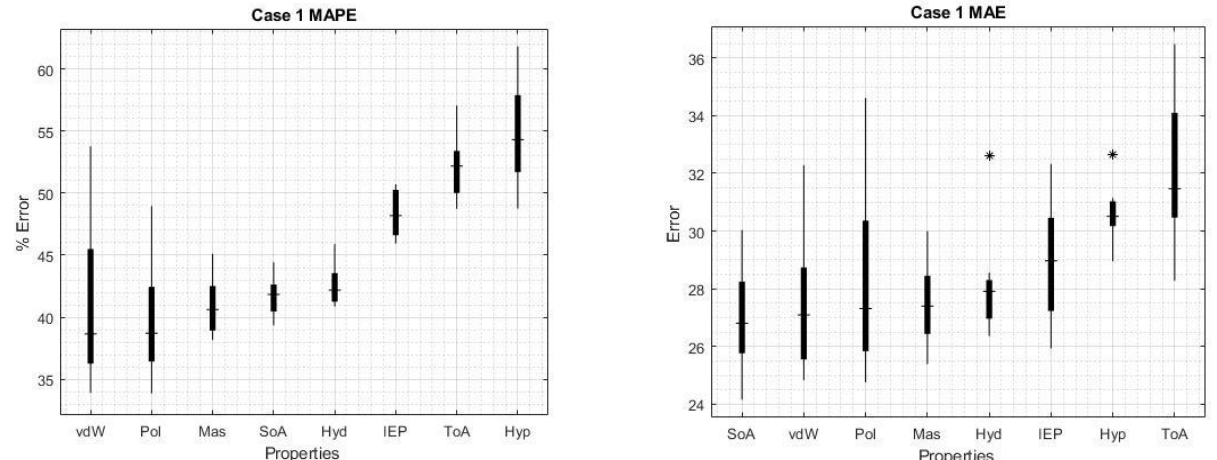
Figure 4. Box plot of the results for case 1. Values obtained for MAPE ( left ) and for MAE ( right ). The characteristics are ordered from the lowest error (implying higher reliability and accuracy) to the highest errors. The * sign denotes outliers.